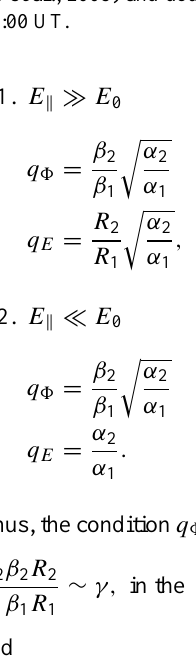
Fig. 6. Comparison of the precipitating electron energy flux in the Northern Hemisphere between Iridium ( a – adapted from Ko- rth et al., 2005) and double resolution LFM (b) from 17:00 UT to 18:00